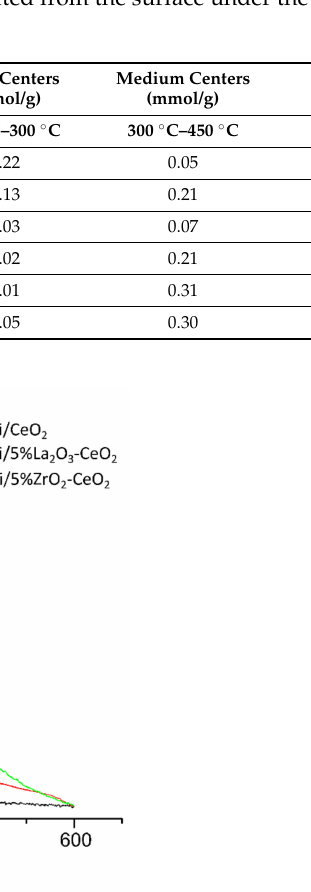
Figure 3. The temperature-programmed desorption of ammonia profiles recorded for 20% Ni/CeO 2 , 1 h at 500 ◦